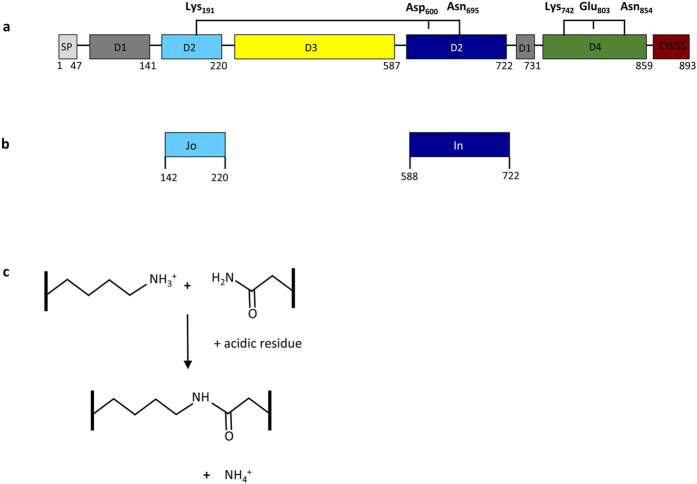
Intramolecular isopeptide bonds in RrgA domains.(a) Schematic topology of RrgA composed of four domains (D1 to D4) in addition to the peptide signal (SP) and the cell wall sorting signal (CWSS). D3 is inserted into D2, and D2/D3 are inserted into D1. D2 and D4 are stabilized by intramolecular isopeptide bonds figured by brackets. In D2, the isopeptide bond between the side chains of Lys191 and Asn695 is stabilized by Asp600. The isopeptide bond in D4 between Lys742 and Asn854 is stabilized by Glu803. D2 is formed by the association of two distinct regions, hereafter called Jo and In, held together by the isopeptide bond. (b) Jo and In constructs. (c) The amide bond formation between Lys and Asn side chains depends on an acidic residue, either Glu or Asp.